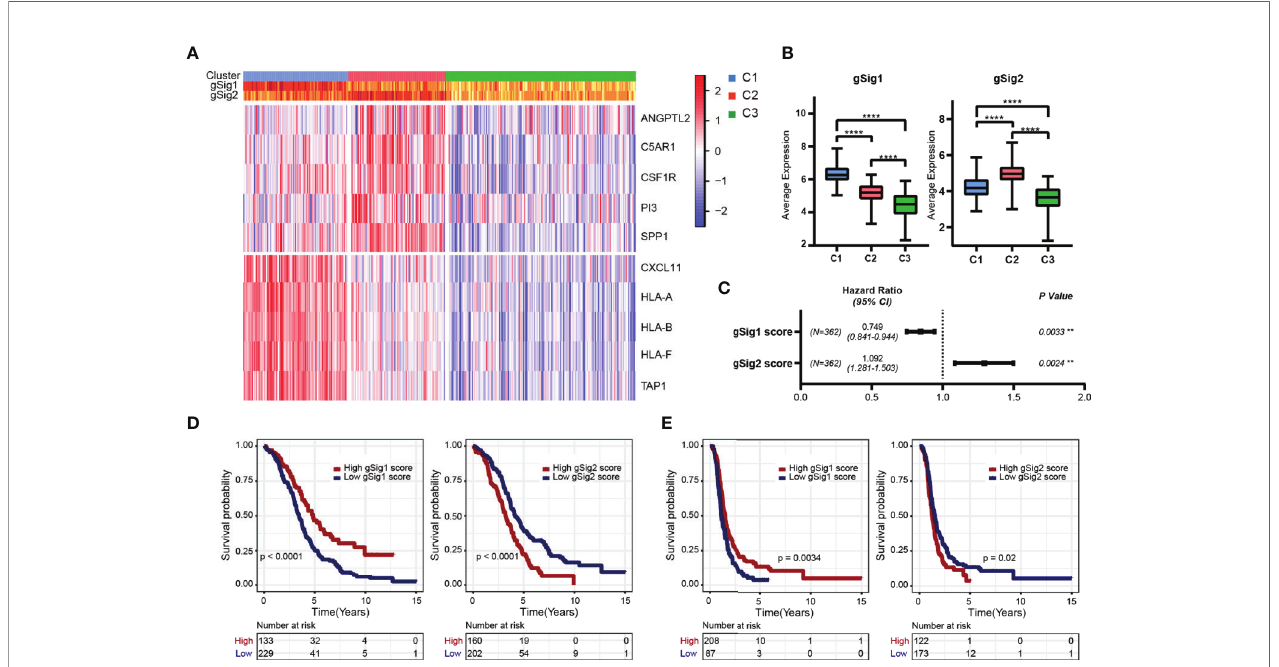
FIGURE 3 | Selection of representative genes. (A) The expression heatmap of representative genes in two gene sets. (B) The expression difference distribution box plot of the gSig1 and gSig2 gene sets between subtypes was analyzed. (C) The prognosis relationship between the two gene sets and OS. (D) Relationship between two gene sets and OS in patients with ovarian cancer. (E) Relationship between two gene sets and PFS in patients with ovarian cancer. **P < 0.01, and ****P <